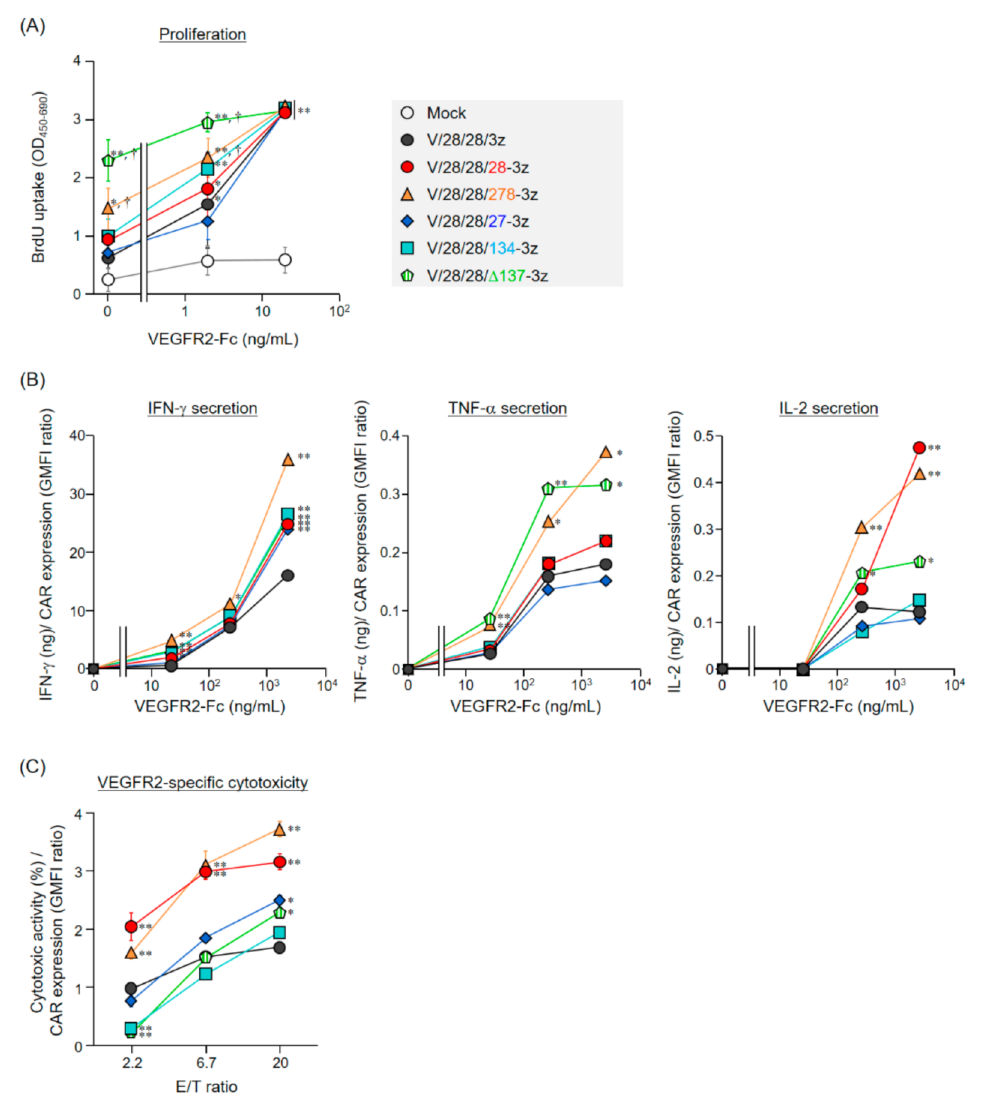
Figure 2. Functional characteristics of mouse T cells expressing second-generation CARs. ( A and B ) CAR-T cells cultured for 4 days after Rv transduction, were stimulated with VEGFR2-Fc (0 − 2000 ng/mL) for 24 h. ( A ) Proliferative activity of STD-modified CAR-T cells following VEGFR2-stimulation. Proliferative activity was analyzed by BrdU uptake ELISA. The data are shown as the mean ± SD of triplicates, and are representative of two independent experiments. Statistical analysis was performed using the Dunnett’s test for multiple comparisons with Mock T cells: * p < 0.05 and ** p < 0.01; and using the Tukey’s test with second-generation CAR-T cells versus first-generation CAR-T cells (V/28/28/3z): † p < 0.05. ( B ) Relationship between CAR expression level and cytokine-producing ability upon stimulation with mouse VEGFR2-Fc in each of the CAR-T cells. The secretion amount of IFN- γ , TNF- α , or IL-2 from CAR-T cells after 24 h stimulation was determined by ELISA. The data are shown as the mean ± SD of triplicates, and are representative of two independent experiments. Statistical analysis was performed using the Dunnett’s test for multiple comparisons with V/28/28/3z: * p < 0.05 and ** p < 0.01. ( C ) Relationship between cytotoxicity at indicated E/T ratio and CAR expression level in each of the CAR-T cells. CAR-T cells were cultured for 4 days after Rv-transduction, and then co-cultured with EL4 cells and VEGFR2 + EL4 cells at an indicated E/T ratio for 18 h. The numbers of EL4 cells and VEGFR2 + EL4 cells in the wells were evaluated by flow cytometry. The cytotoxic activity against VEGFR2 + EL4 cells was calculated from the ratio between the numbers of VEGFR2 + EL4 cells and EL4 cells. The data shows the mean ± SD of triplicates and are representative of three individual experiments. Statistical analysis was performed using the Dunnett’s test for multiple comparisons with V/28/28/3z: * p < 0.05 and ** p <